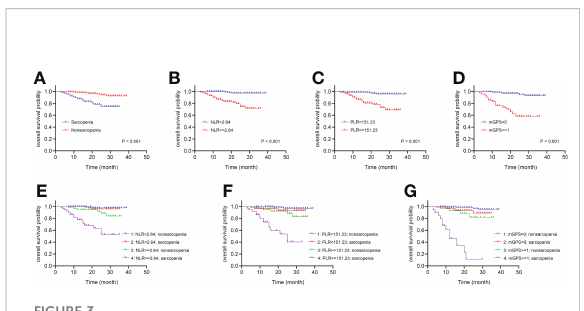
FIGURE 3 The Kaplan-Meier curves of sarcopenia, systemic in fl ammatory markers and the combinations for patients following nephrectomy. (A) OS for patients with or without sarcopenia. (B) OS for patients with high or low NLR. (C) OS for patients with high or low PLR. (D) OS for patients with high or low mGPS. (E) Four combinations of sarcopenia and NLR. (F) Four combinations of sarcopenia and PLR. (G) Four combinations of sarcopenia and mGPS. OS, overall survival; NLR, neutrophil-to- lymphocyte ratio; PLR, platelet-to-lymphocyte ratio; mGPS, modi fi ed Glasgow Prognostic Score.